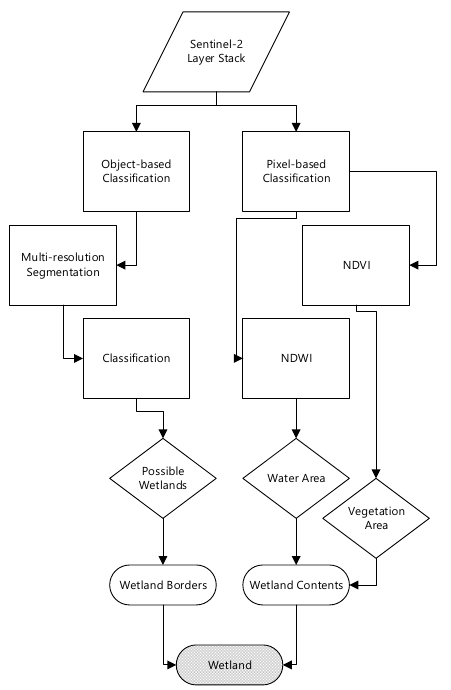
Figure 6. Workflow of the new proposed method